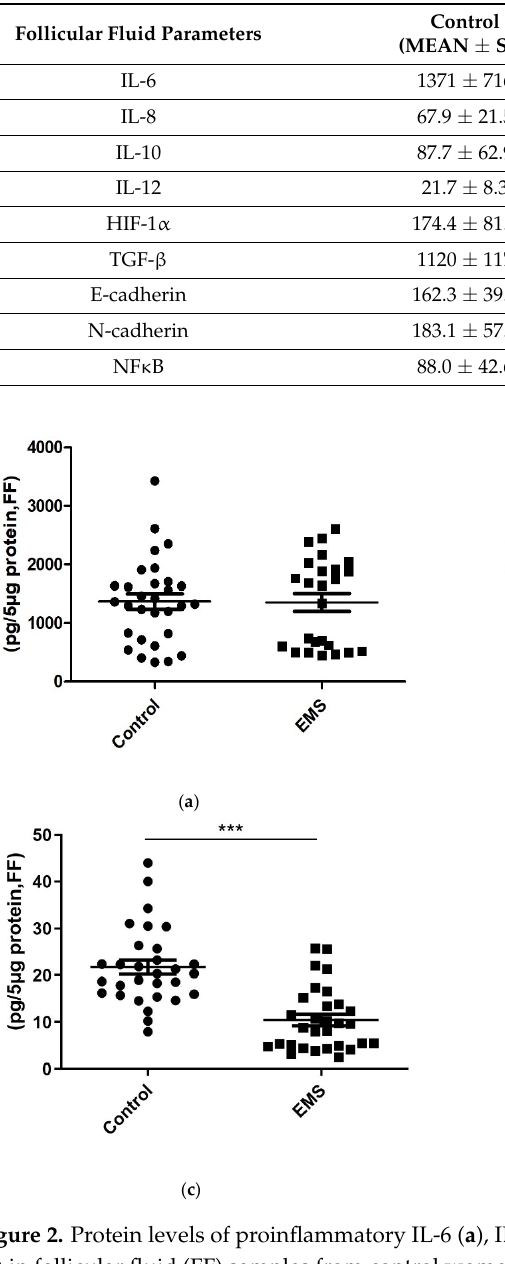
Figure 2. Protein levels of proinflammatory IL-6 ( a ), IL-8 ( b ), IL-12 ( c ), and anti-inflammatory IL-10 ( d ) in follicular fluid (FF) samples from control women and EMS patients. The data are reported as the mean values ± SD of three independent experiments each performed in duplicate. Statistical analysis was performed by unpaired t -test: *** p < 0.001 versus control.